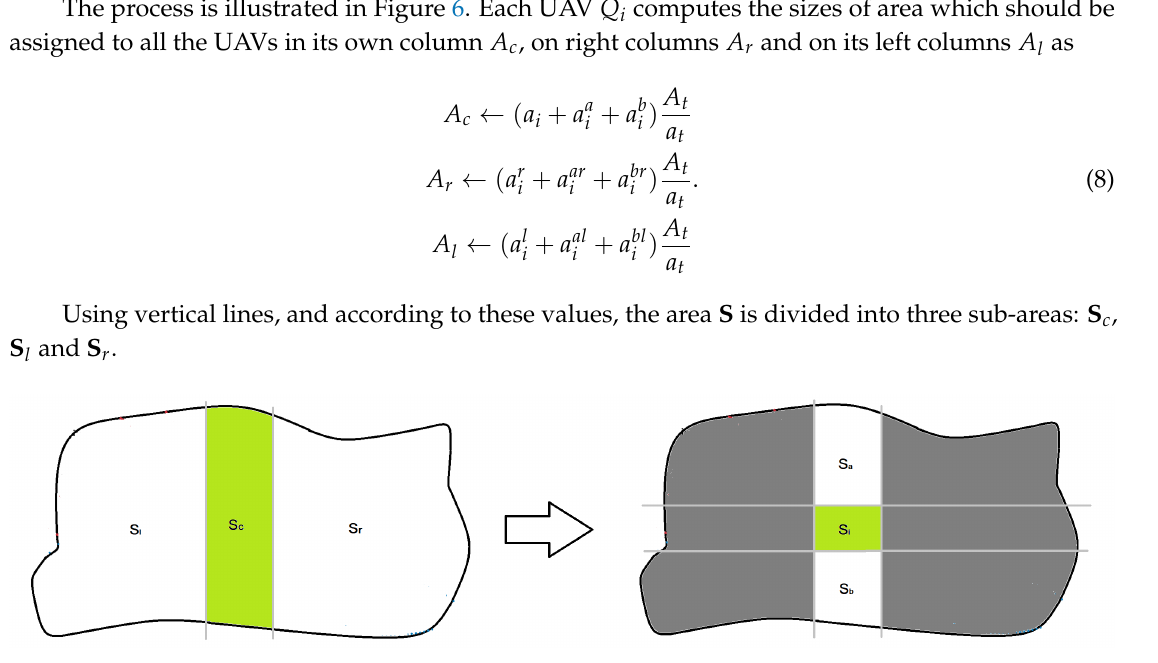
Figure 6. Area division protocol used by each UAV Q i to self-assign its own sub-area S i . For each step, gray lines are used to make divisions and the green polygon is the chosen